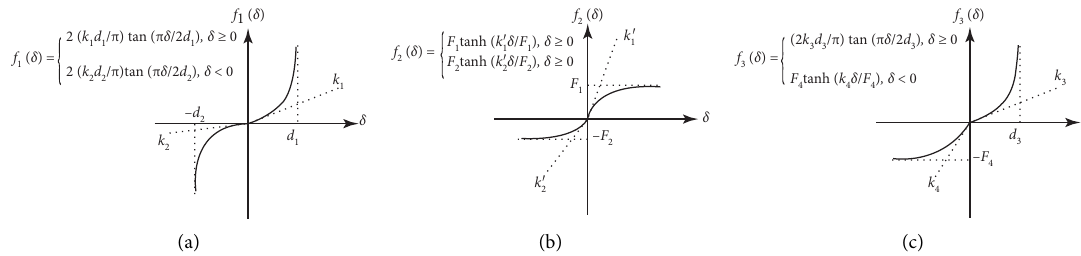
Figure 2: Three types of restoring forces of packaging cushion materials. (a) Antisymmetry tangent type. (b) Antisymmetry hyperbolic tangent type. (c) Asymmetric tangent-hyperbolic tangent type.